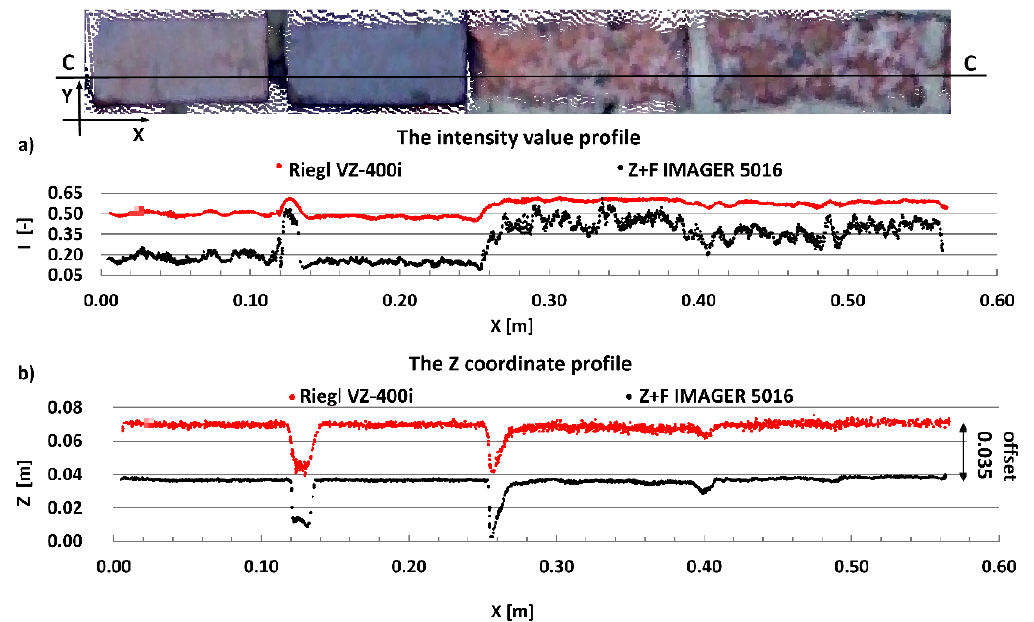
Figure 6. CC profiles—brick walls from different periods of time: ( a ) intensity data profile and ( b ) geometric data profile.